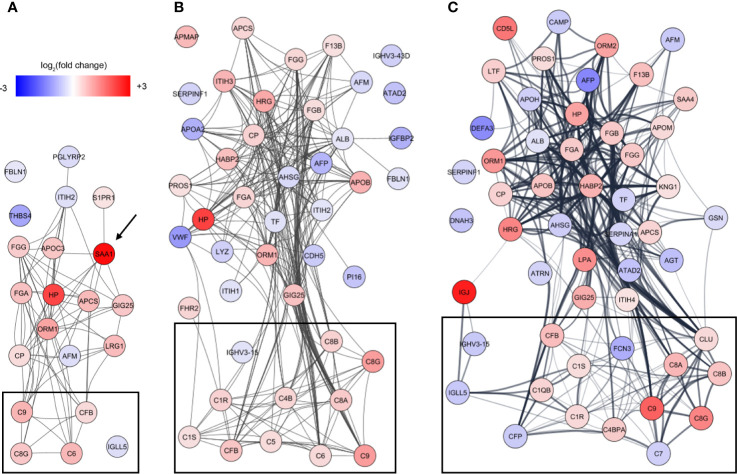
Analysis of protein-protein interactions of the differentiating proteins at (A) DOL1, (B) DOL3, and (C) DOL7 compared to DOL0 (at birth). SAA1 which was regulated at DOL1 only is indicated with an arrow, and lines indicate interacting proteins. Proteins tagged as complement system in Gene Ontology are indicated with black boxes without further curation.